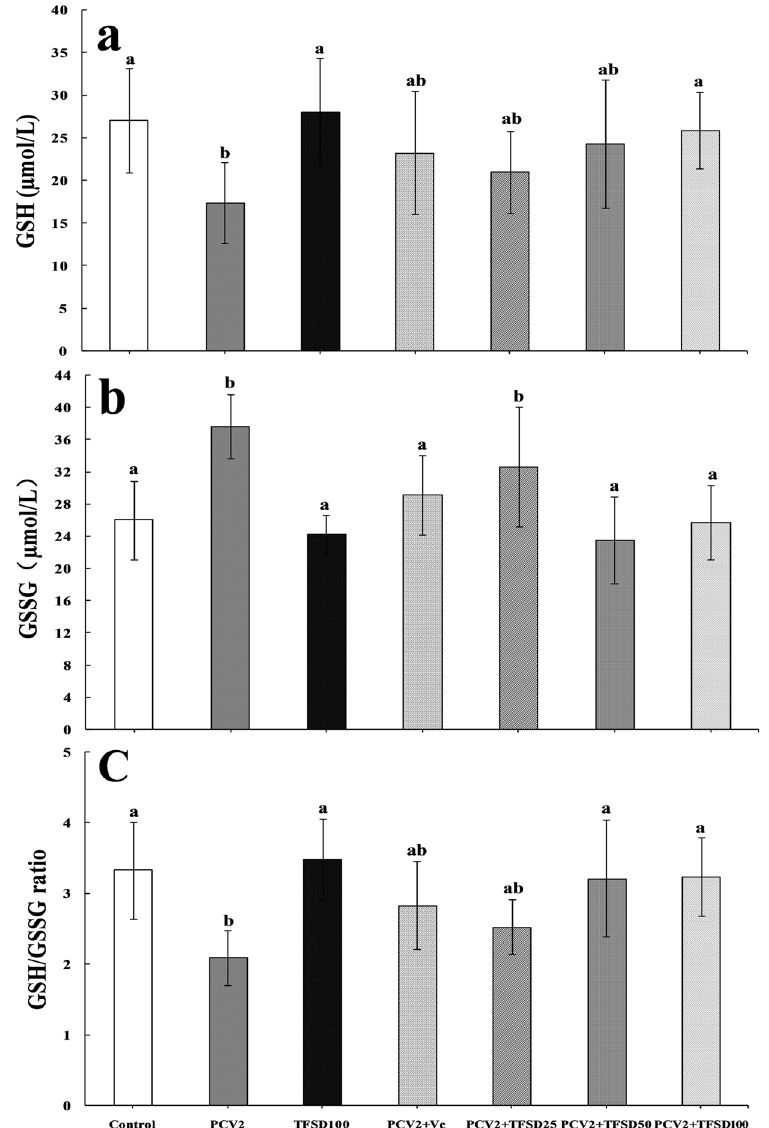
Figure 5. Effect of TFSD on GSH content, GSSG level and GSH to GSSG ratio in the spleen tissue of PCV2 infected mice. Data are presented as mean ± SD (n = 10). Bars with different letters are statistically different ( P <